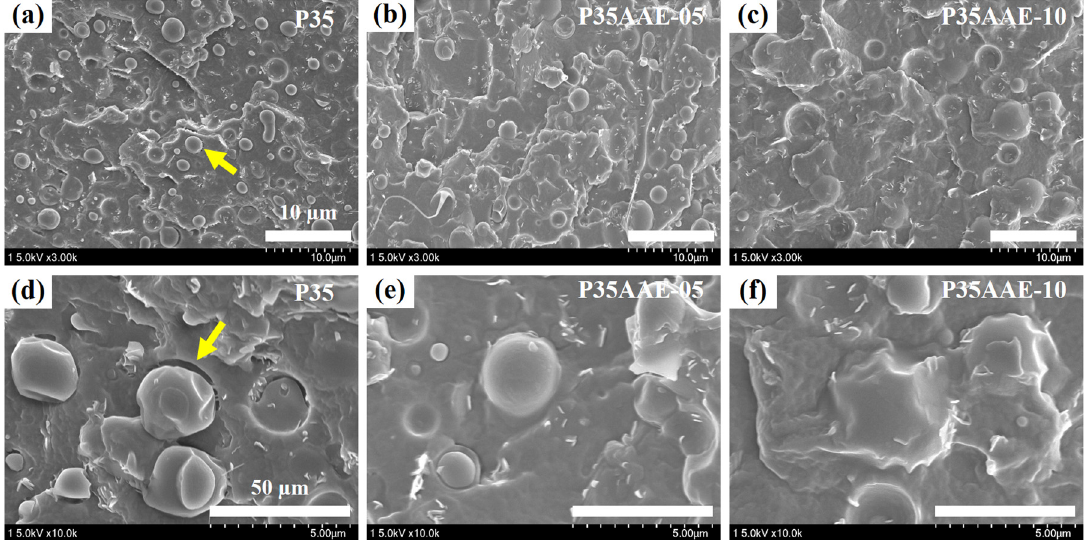
Figure 4. SEM micrographs of the fractured surfaces of the PLA / PBAT and plasticized PLA / PBAT blends at low (upper, scale bar: 10 µm) and high (lower, scale bar: 50 µm) magnifications: ( a , d ) P35, ( b , e ) P35AAE-05, and ( c , f ) P35AAE-10.